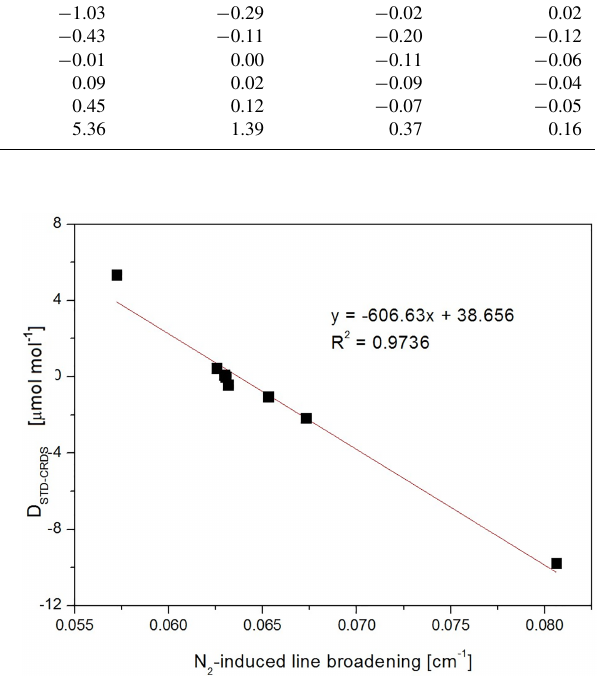
Figure 3. N 2 -induced line broadening ( x axis) vs. difference be- tween CRDS-measured and assigned CO 2 levels of standard gas mixtures ( y